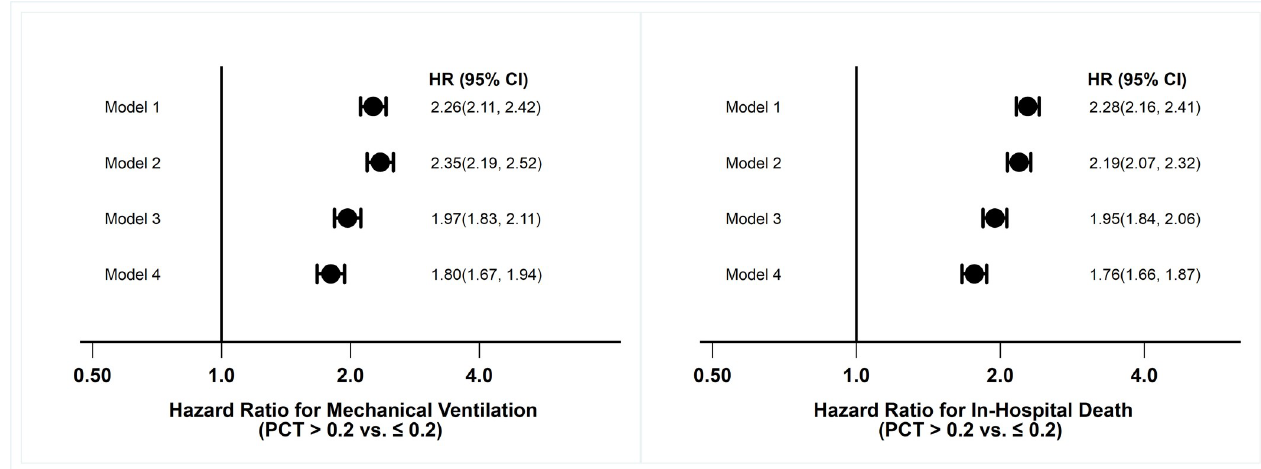
Fig 3. Forest plots showing the hazard ratios for mechanical ventilation and in-hospital death. Model 1 is unadjusted. Model 2 adjusted for demographic and comorbidity conditions (i.e., adjusted for age, race, BMI, history of CKD, Heart failure, hypertension, liver disease, and diabetes), Model 3 adjusted for demography, comorbidity conditions (Model 2) as well as pneumonia (presence or absence) and antibiotic use (used or not used). Model 4 adjusted for all covariates of Model 3 and lab test results (CRP, WBC, and lactate).